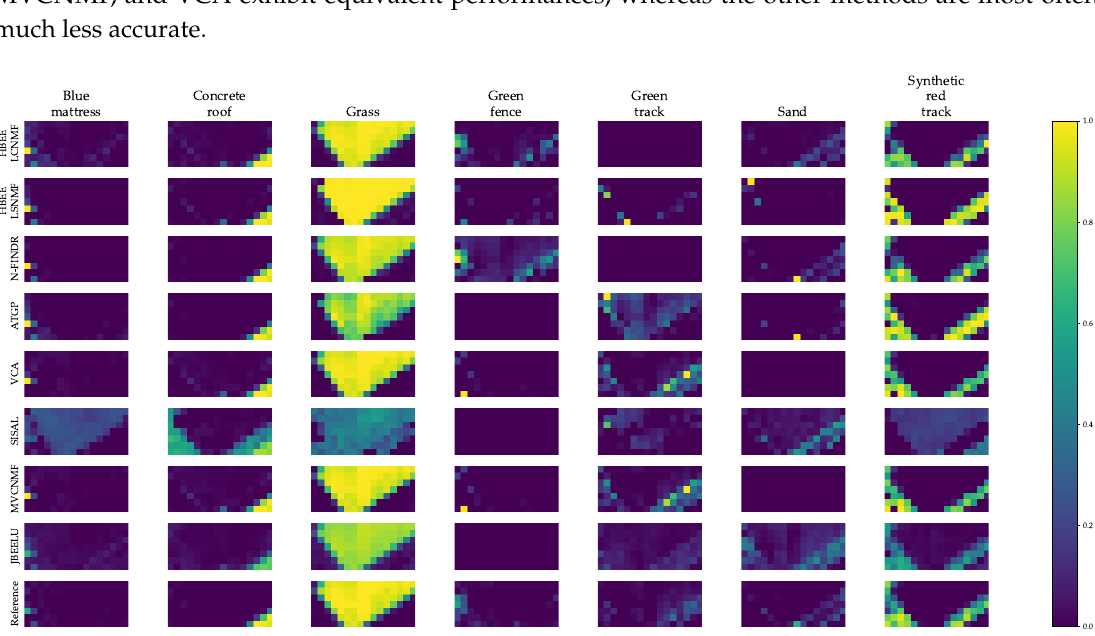
Figure 14. Estimated abundance fractions for the Basel data set based on the SAM of the estimate- reference spectrum